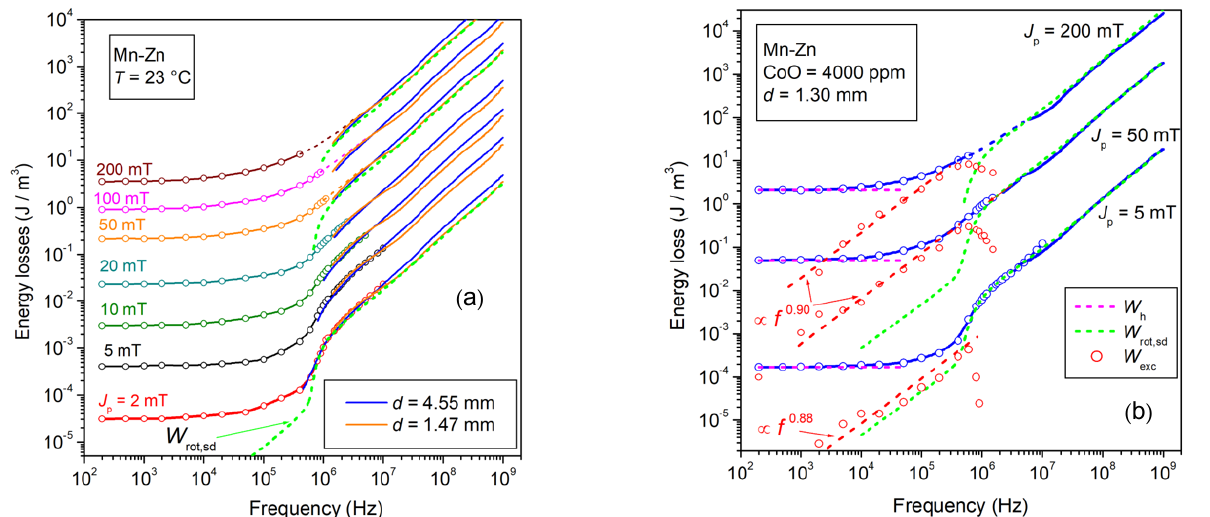
Figure 7. ( a ) Broadband energy loss in an Mn-Zn ferrite ring measured from J p = 2 mT to J p = 200 mT before and after reduction of the sample thickness d from 4.55 mm to 1.47 mm. An eddy current loss contribution is observed before thinning in the upper-frequency range ( f > 10 MHz). The rotational loss by spin damping W rot,sd ( f ), calculated by Equations (29a) and (29b) (dashed lines), fully predicts the measured loss in the thinner ring from 800 kHz and 3 MHz onward for J p = 2 mT and J p = 200 mT, respectively. ( b ) W ( J p , f ) is decomposed as W